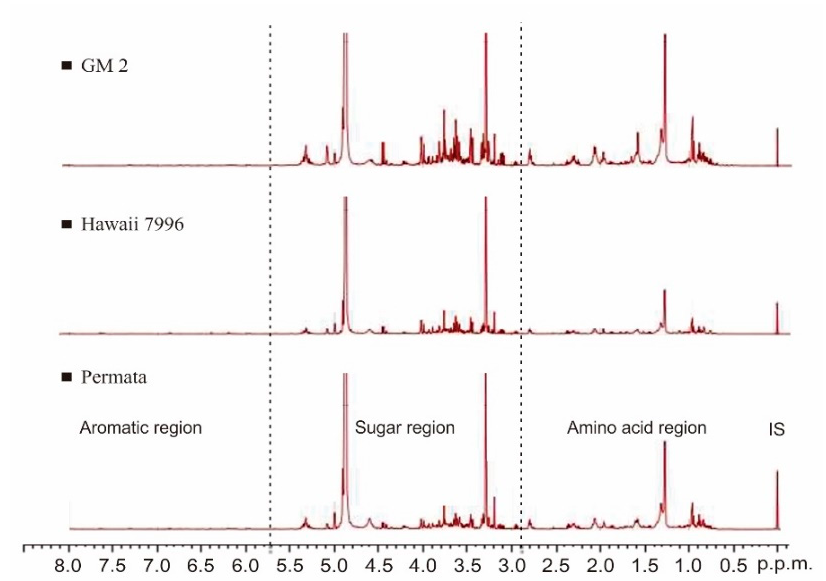
Figure 2. 1 H-NMR spectra of tomatoes show different peak intensities among three cultivars. IS: internal standard TMS. Table 1. Peak assignments for the 1 H-NMR spectrum of tomato leaf in Methanol-d4 (MeOD 4